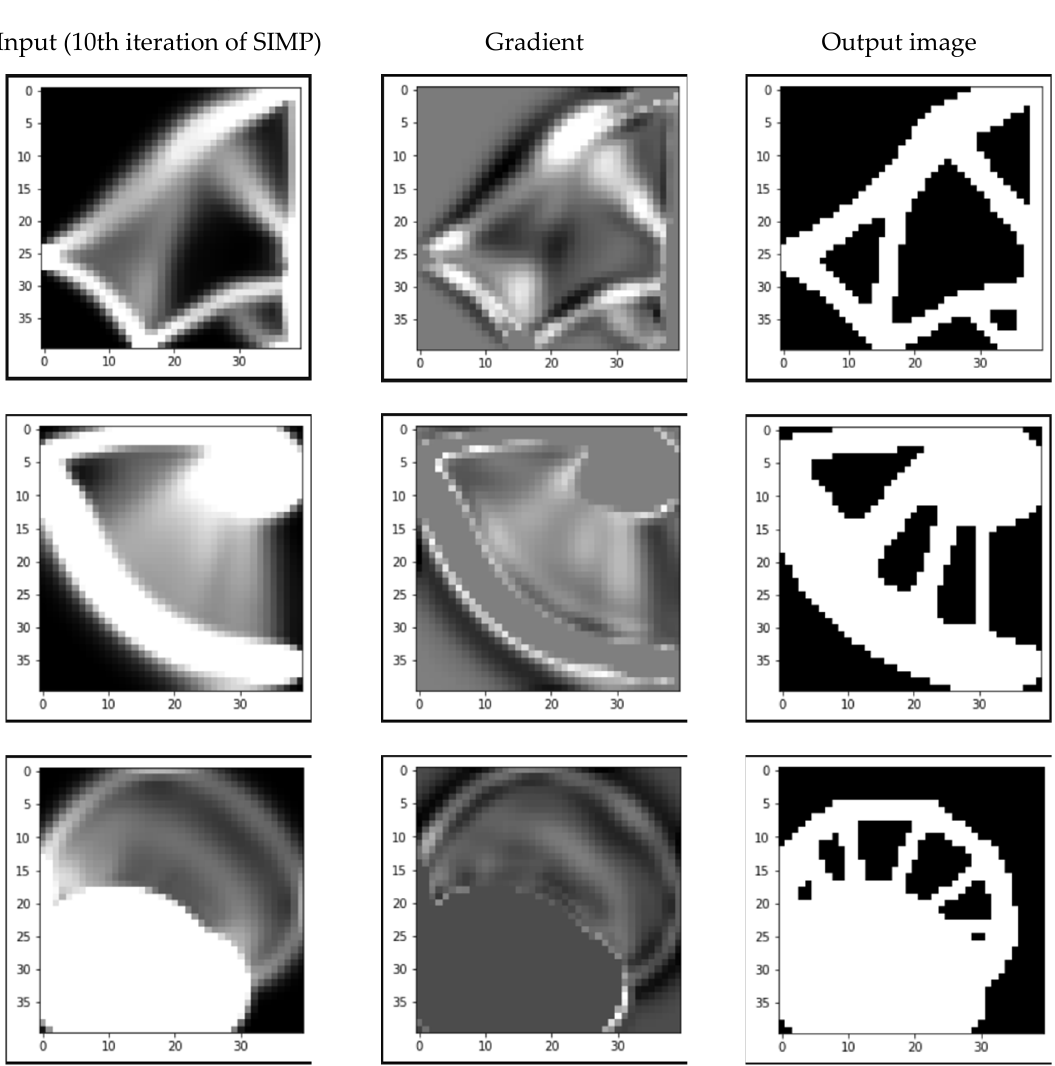
Figure 2. Images of input, output and gradient of sample in the dataset #1.